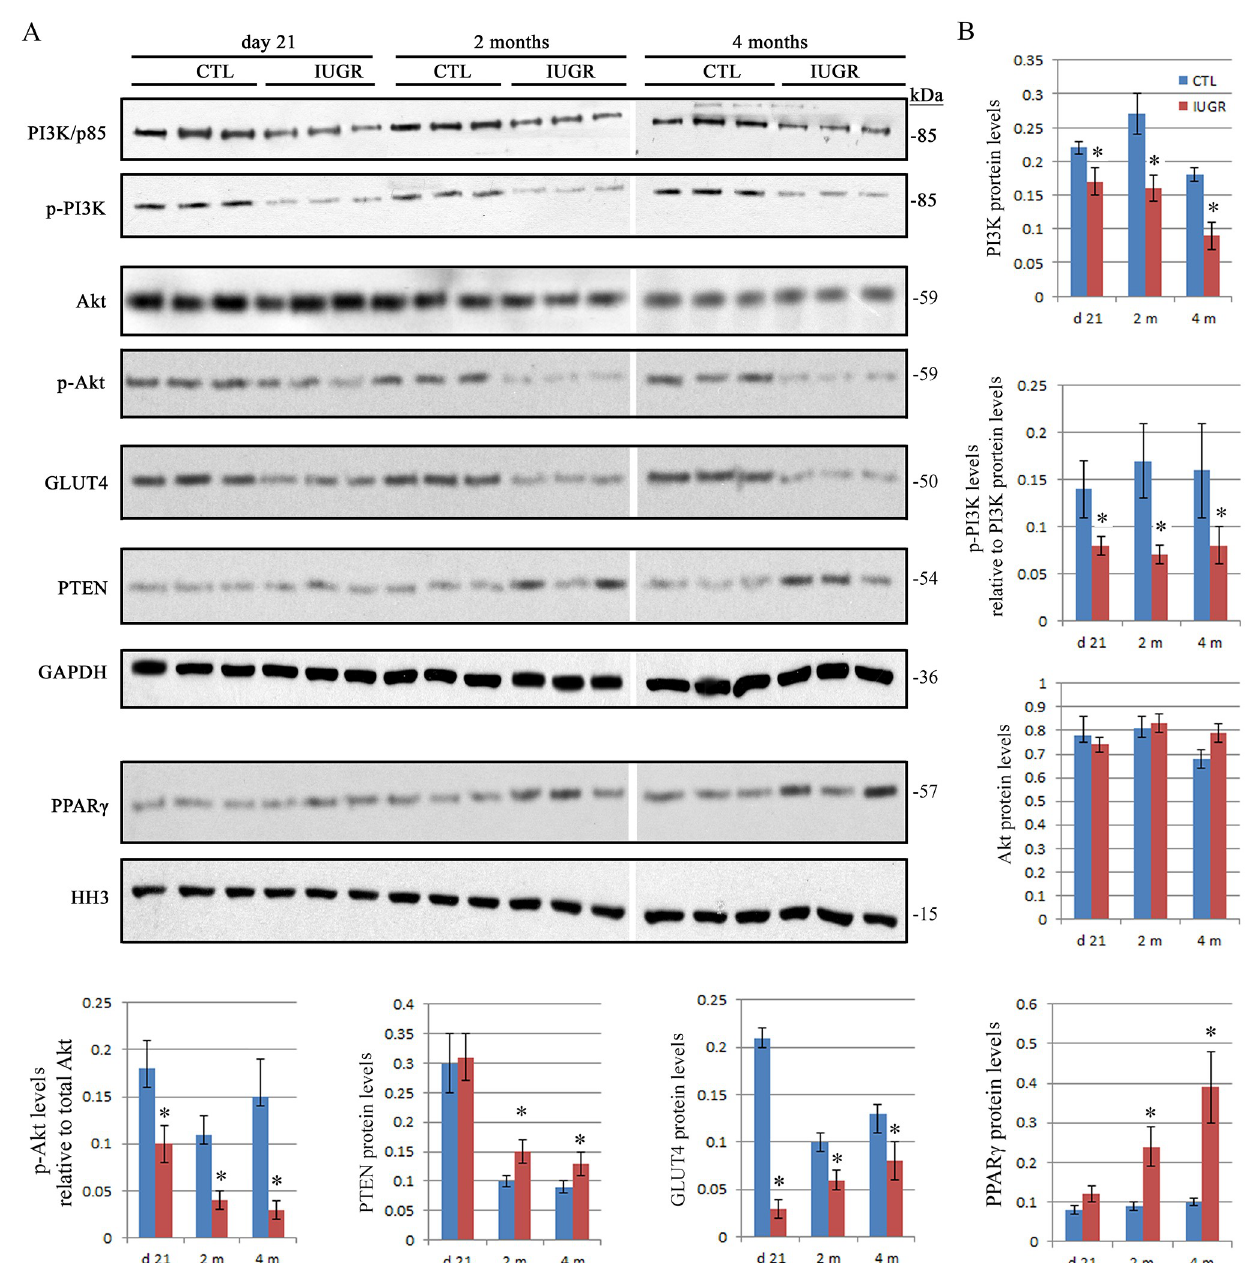
Fig 3. Dynamic changes of the protein levels of phospho-PI3K, phospho-Akt, PTEN, GLUT4 and PPAR γ in skeletal muscle tissues of the IUGR offsprings. A. The representative western blot images are shown for PI3K, phospho-PI3K, Akt, phospho-Akt, PTEN and GLUT4 as well as the nuclear PPAR γ . B. Graphed is the relative abundance of the total PI3K p85, Akt, PTEN and GLUT4 as well as PPAR γ normalized to the housekeeping gene GAPDH and histone H3 (HH3), respectively. The levels of phospho-PI3K p85 Tyr458 /p55 Tyr199 , phospho-Akt Ser473 relative to the total PI3K p85 and Akt was compared, respectively. In comparison with the controls, the protein levels of total PI3K as well as the phospho-PI3K, phospho-Akt and GLUT4 were significantly lower at all three time points in the IUGR offsprings. At 2 and 4 months, the levels of PTEN and nuclear PPAR γ were significantly higher in the IUGR offsprings than that in the controls. Total Akt did not show significant differences between the IUGR offsprings and the controls. Data are shown as mean ± SD . n = 15 , � p < 0 . 05 vs . CTL .